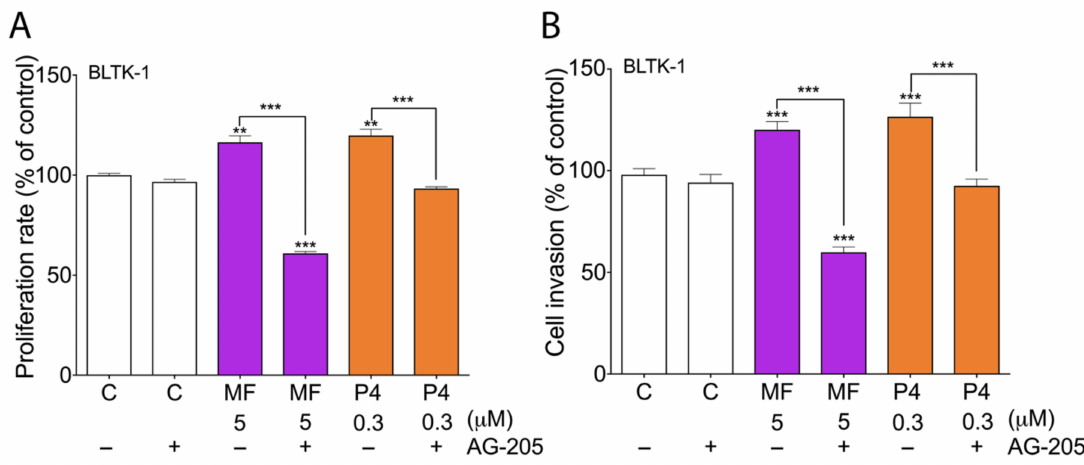
Figure 4. Proliferation of BLTK-1 cells with MF, P4 or PGRMC1 inhibitor treatments. E ff ects of MF and P4 with or without the AG-205 inhibitor on BLTK-1 cell proliferation after 24 h treatment, measured by BrdU assay ( A ). Cell proliferation of the treated groups is presented as the percentage of the control (considered as 100%). E ff ects of MF and P4 with or without the AG-205 inhibitor on BLTK-1 cell invasion after 24 h treatment ( B ). Cell invasion of the treated groups is presented as the percentage of the control group (considered as 100%). Asterisks indicate significant di ff erences between the control and treated groups (**, p < 0.01; ***, p < 0.001). AG-205, PGRMC1 inhibitor; C, control; LCT, Leydig cell tumor; MF, mifepristone; P4,